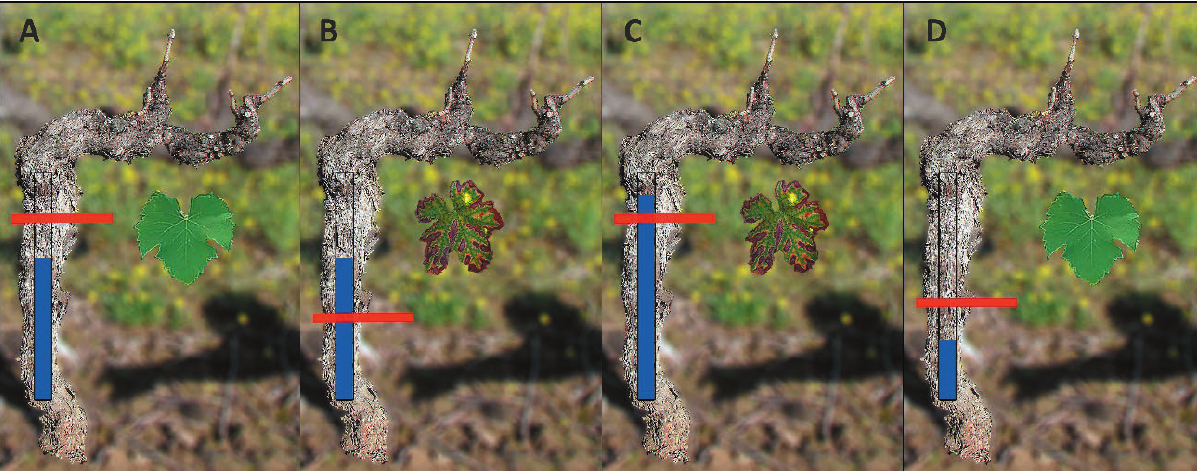
Figure 2. The results of joint effects of different factors on the edge hypothesis. Blue bars represent the hypothetical abundance of LSSIM in grapevine perennial and/or annual organs. Red bars represent the hypothetical edge, above which hosts manifest leaf symptoms. In leaf asymptomatic vines (A and D), LSSIM abundance remains below the threshold. In leaf symptomatic plants (B and C), the threshold is sur- passed. Biotic and abiotic factors may act as stressors, contributing to lowering the threshold (B and